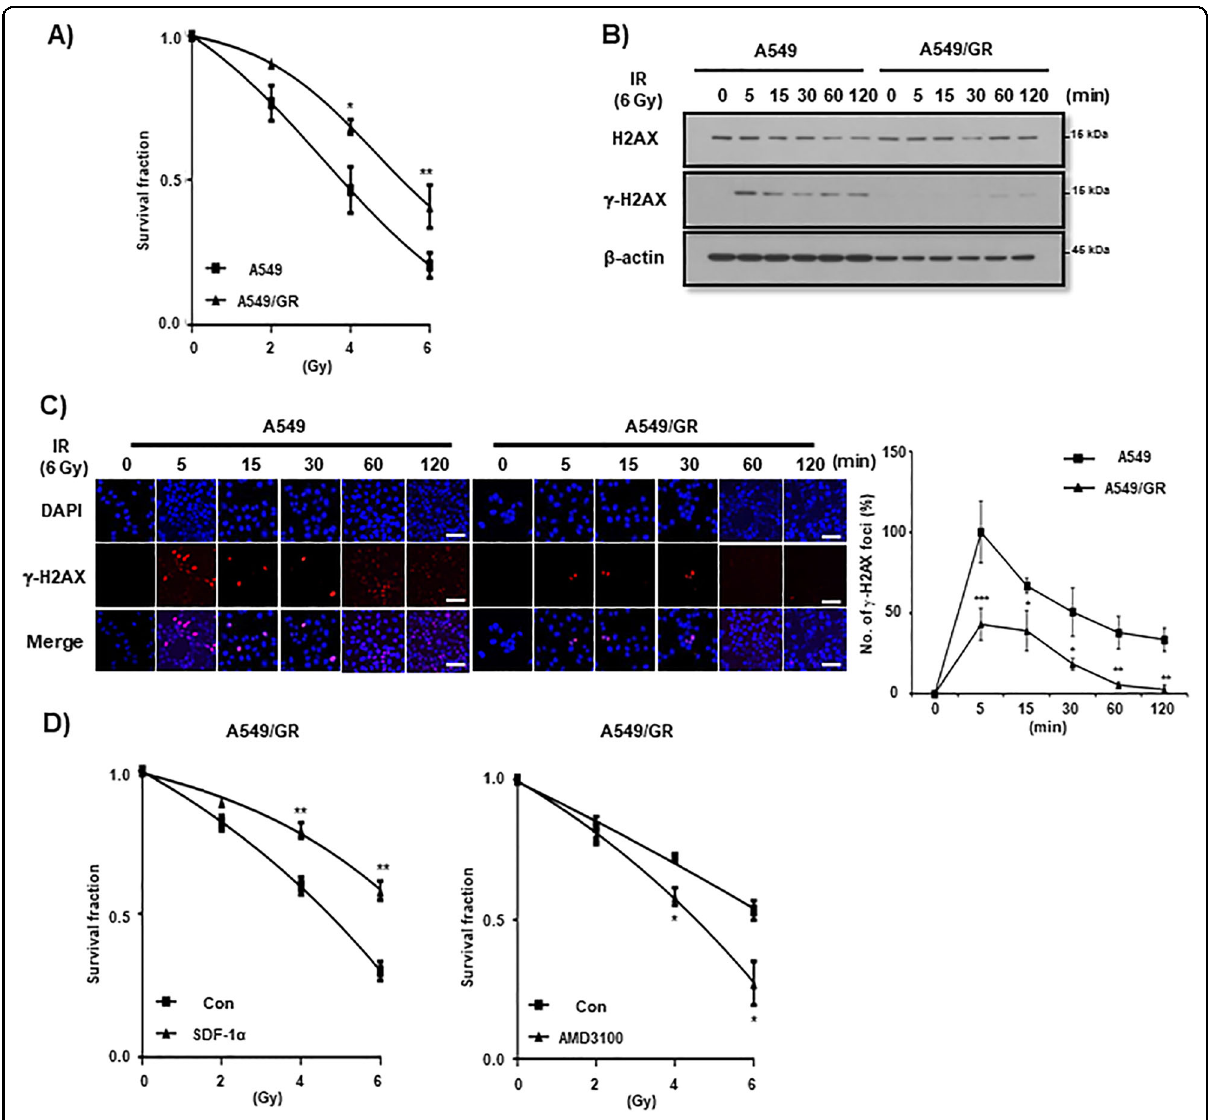
Fig. 1 Drug resistant A549/GR cells are more resistant to IR than parent A549 cells. A IR clonogenic assay of A549 and A549/GR cells. Cells (2.5 × 10 2 ) were exposed to IR at various doses described in the Figure. IR-exposed cells were cultured in complete medium and evaluated colony- forming activity at 10 days after IR exposure. B Western blot analysis of A549 and A549/GR cells. Cells were seeded in complete medium. Next day, cells were exposed to IR at 6 Gy and lysed in lysis buffer at various time points indicated in the Figure. C γ -H2AX foci assay of A549 and A549/GR cells. ICC was performed with A549 and A549/GR cells using γ -H2AX antibody. The images were obtained from A549 and A549/GR cells exposed to 6 Gy of IR at the indicated time points described in the Figure (left). Graphs represented statistical analysis of ICC data (right). Nuclei were counterstained with DAPI (blue). White bar: 20 μ m. D IR clonogenic assay of A549/GR cells treated with or without SDF-1 α (100 ng/ml) (left) and AMD3100 (10 μ M) (right). * P < 0.05, ** P < 0.01, *** P <